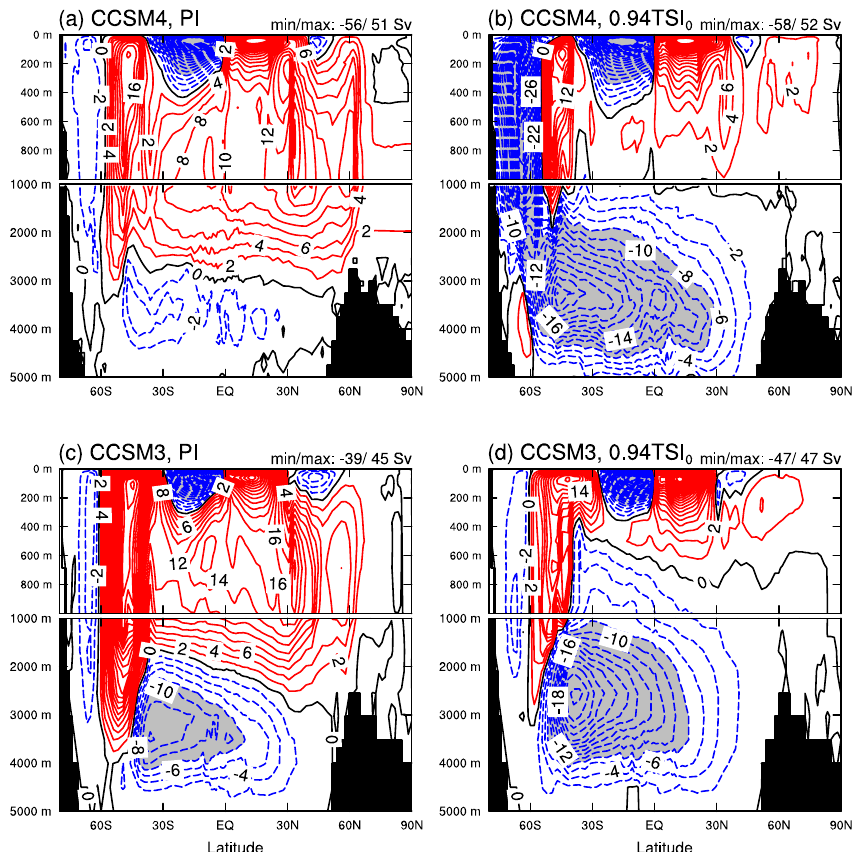
Fig. 4. Same as Fig. 3, but for the global